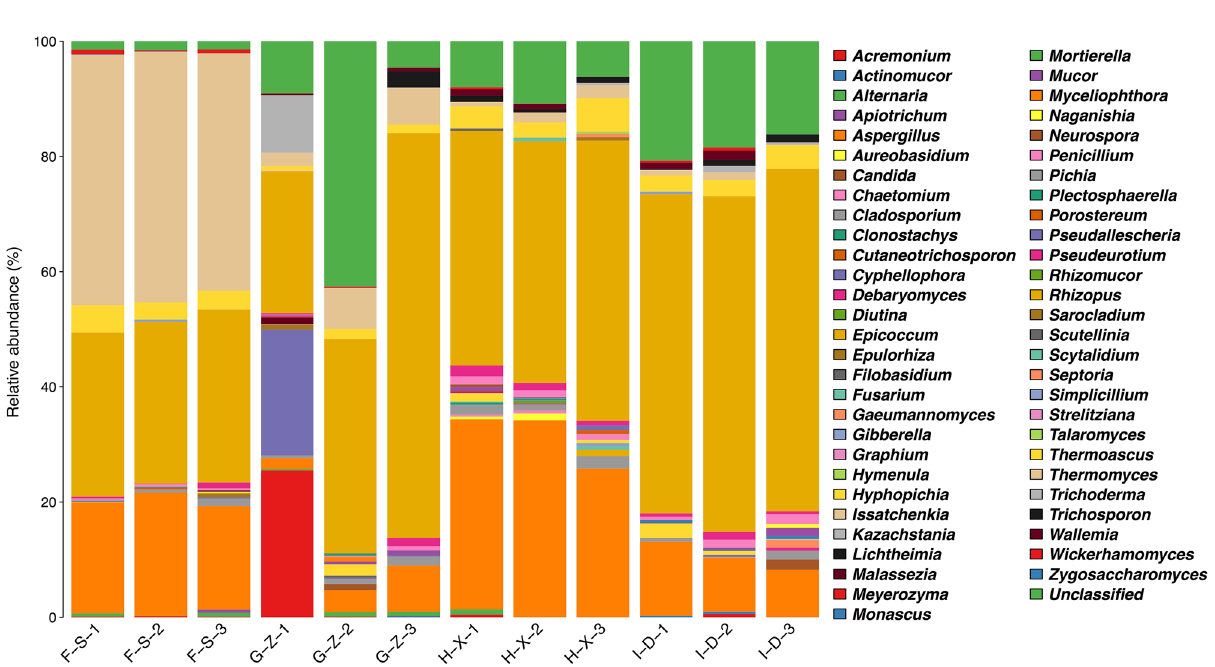
Figure 5. Stack diagram showing the species distribution of fungi in pit mud from F-S, G-Z, H-X and I-D at the genus